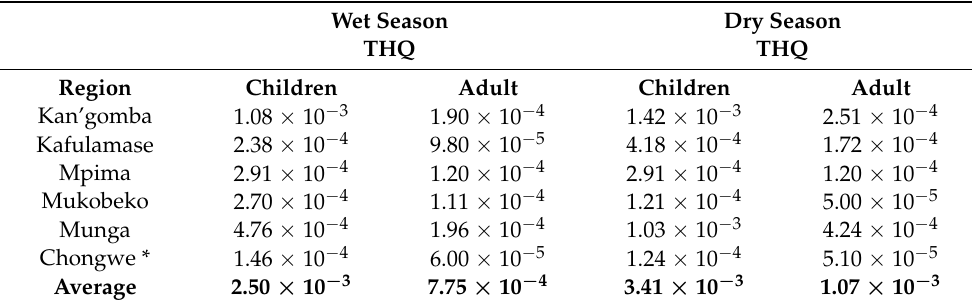
Table 4. Target hazard quotient (THQ) of lead through consumption of cow milk (in children and adults) in the residents of Kabwe.